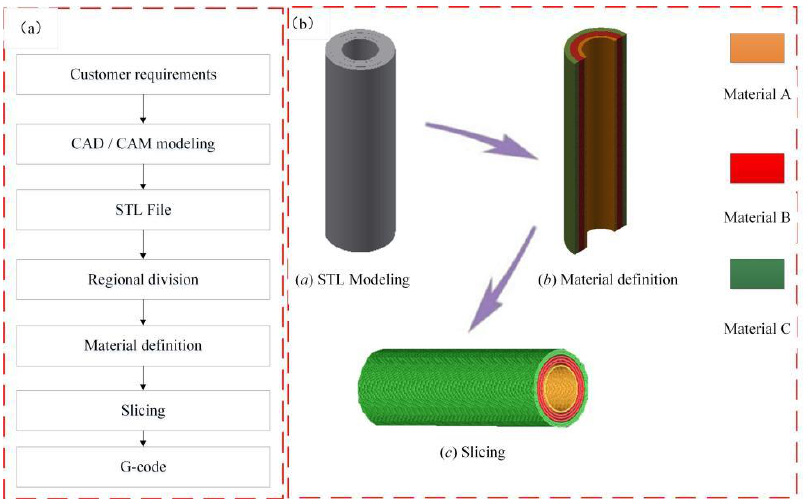
Figure 4. Vascular structure construction. ( a ) Model building process; ( b ) Material distribution in different areas of the vessel-like structure.